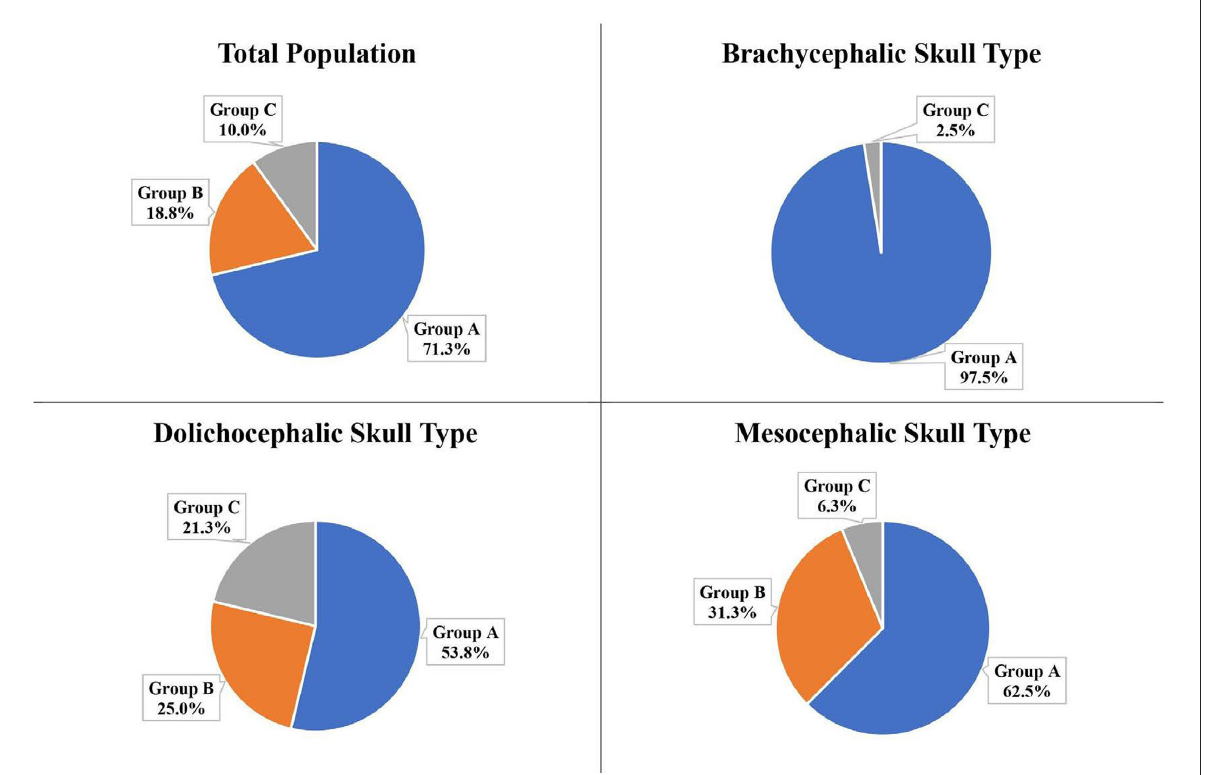
FIGURE11 Portion of the IOC within Section 12 at the distal root of the P4 for the total population and the three different skull types: Group A: No IOC in Section 12; Group B: 0 < IOC ≤ 1/3; Group C: 1/3 < IOC ≤ 2/3; Group D: 2/3 < IOC < 1; Group E: Entire IOC in Section 12. *Groups not pictured had